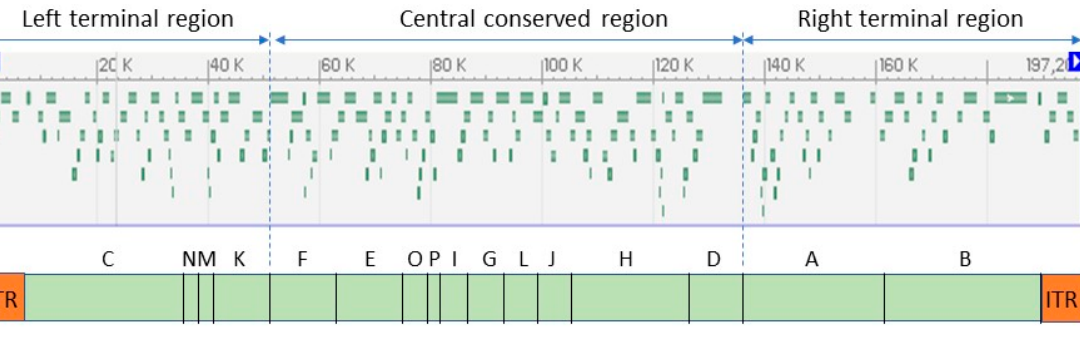
Figure 2. Open reading frames (ORF) identifiable in the monkeypox virus reference sequence (NC_063383; 197,209 bp) ( above ), and genomic sections in which they are organized ( below ). Adapted from GenBank and ViralZone.